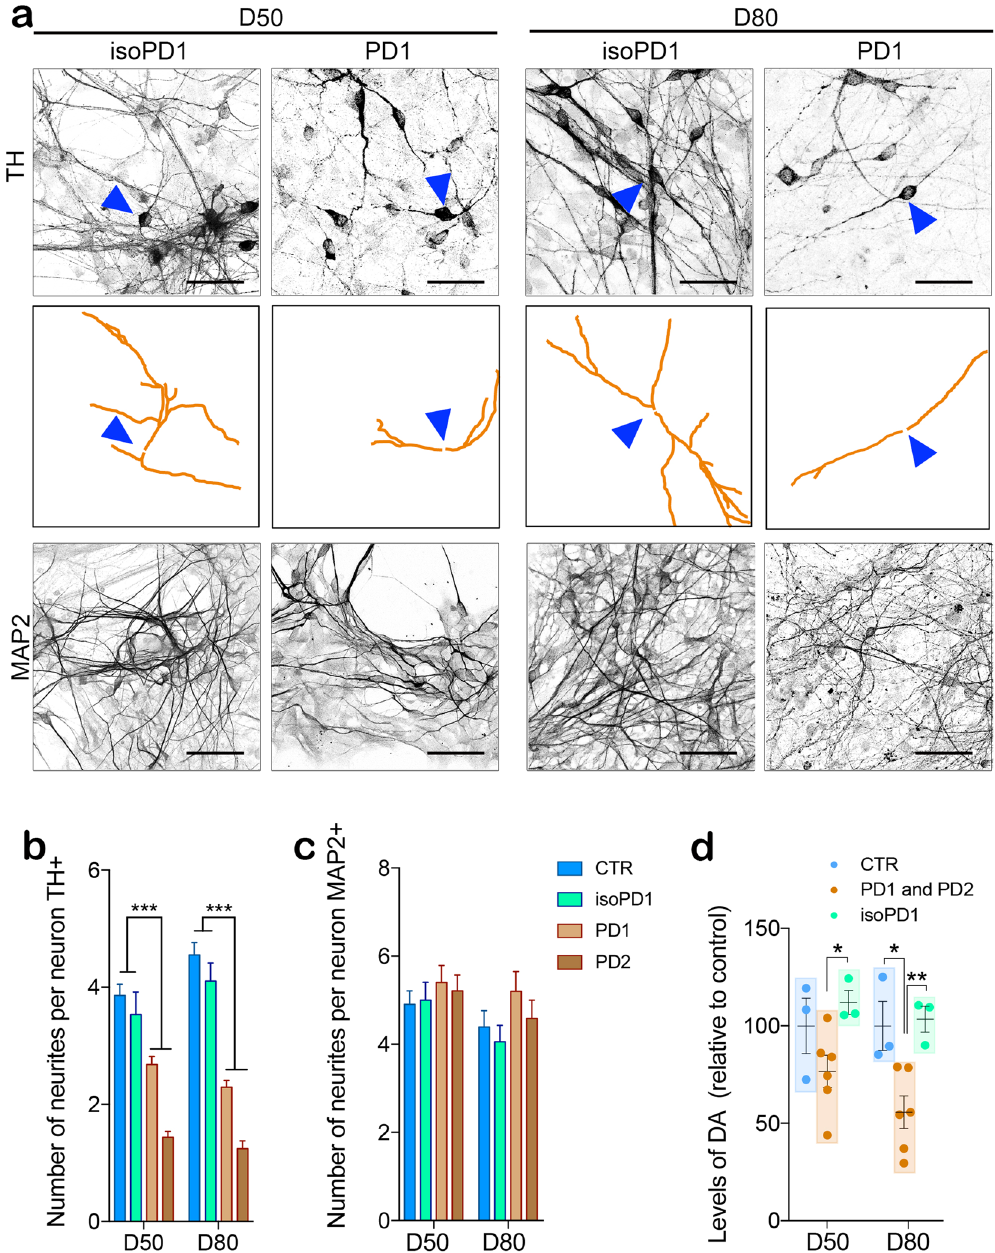
Fig. 6 Biological con fi rmation of the in silico hypothesis. a Gene-edited isoPD1 (SP12 wt/wt) and PD1 (SP12) TH + neuronal processes are traced (orange) to determine the number and the structure of neurites at D50 (left panels) and D80 (right panels). The top panels for each cell line show the original image of TH + neurons. A blue triangle highlights a representative traced neuron shown in the middle panels. The bottom panels for each cell line show MAP2 + neuronal processes. Scale bar is 50 μ m in all images. b The quanti fi cation of the number of TH neurites shows signi fi cant differences between CTR and PD1 both at D50 and D80. c No differences are detected on the number of MAP2 neurites. d Levels of released DA measured in culture media from CTR (SP11), PD1 (SP12), PD2 (SP13), and isoPD1 (SP12 wt/wt) at D50 and D80 of differentiation, relative to CTR levels. * p -value < 0.05; ** p -value < 0.01; *** p -value < 0.001 (ANOVA with multiple comparison analysis). Number of independent experiments n = (Table 1). Moreover, the con fi rmation of our fi ndings in neuronal variability described among iPSC lines and clones 25 . To rule out cultures differentiated from gene-edited isogenic controls of PD the impact of interline/interclone variability in our fi ndings, we iPSC provides further reassurance that the alterations identi fi ed in used several iPSC lines and iPSC clones to represent each PD samples in our studies are indeed related to the disease experimental condition. Speci fi cally, controls included two inde- condition, rather than re fl ecting the speci fi c iPSC line/clone pendent iPSC lines generated from two independent individuals, utilized. and a total of four iPSC clones, whereas the PD condition was Our previous work showed that PD patient-speci fi c iPSC-derived similarly represented by two independent iPSC lines generated DAn are particularly susceptible to undergo neurodegeneration from two independent individuals, and a total of three iPSC clones